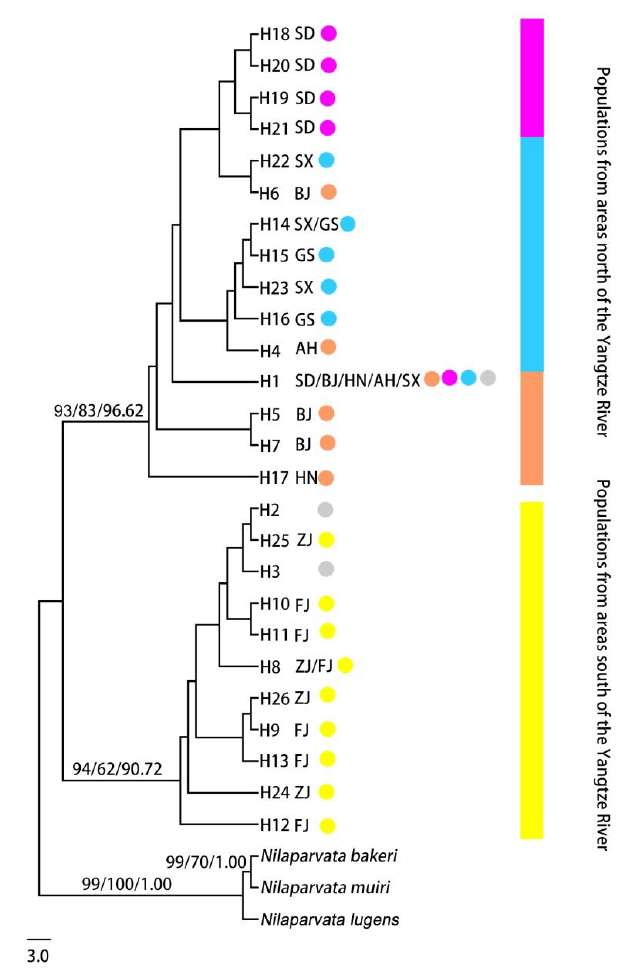
Figure 3. The phylogenetic tree of Lycorma delicatula populations in China, Korea, and Japan using neighbor-joining, maximum likelihood, and Bayesian inference. The haplotypes of Korea and Japan are H1; except for the haplotypes of Tiantai, Ningbo (H3) and Linan (H2), the other haplotypes of China are H1 [10]; the gray is used to represent these downloaded haplotypes. ZJ and FJ populations are in areas south of the Yangtze River; the other populations are included in areas north of the Yangtze River. The colors are the same as the major clusters of populations inferred by STRUCTURE analysis when K = 4. The bootstrap values of NJ and ML and the posterior probability of BI are given ( >